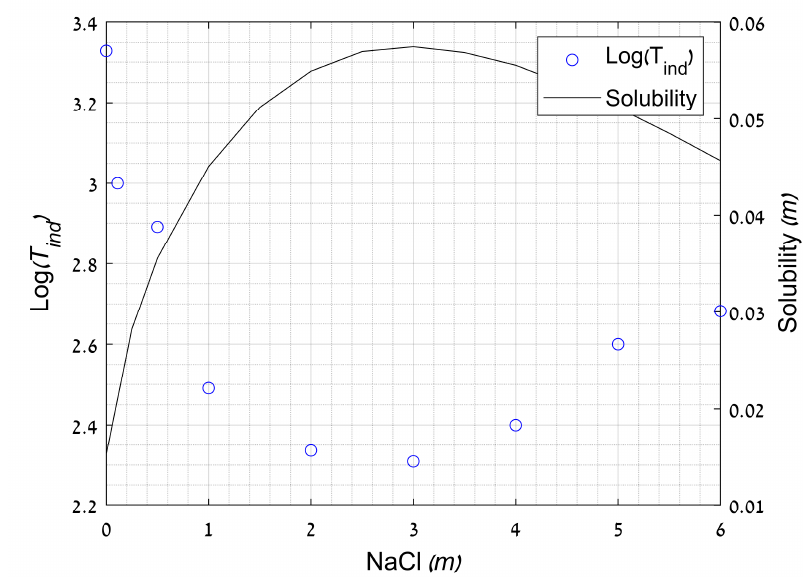
Figure 5. Measured Log( T ind ) for gypsum as a function of salinity in stoichiometric NaCl solutions at 25 ◦ C and Ω gypsum = 3 vs. the calculated solubility of gypsum. Log( T ind ) data points are from He et al. [77]; the calculated solubility data were calculated with the pitzer.dat database in PHREEQC 2.18 for 25 °C.